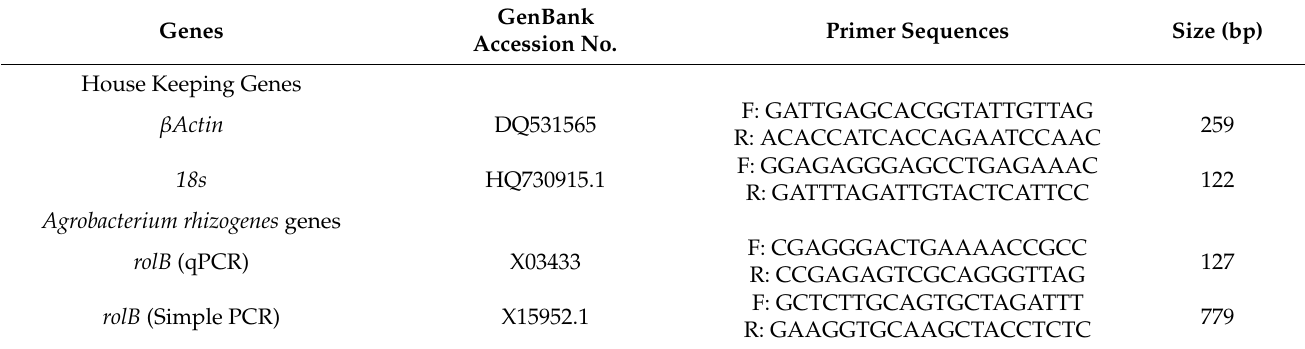
Table 7. The gene primer